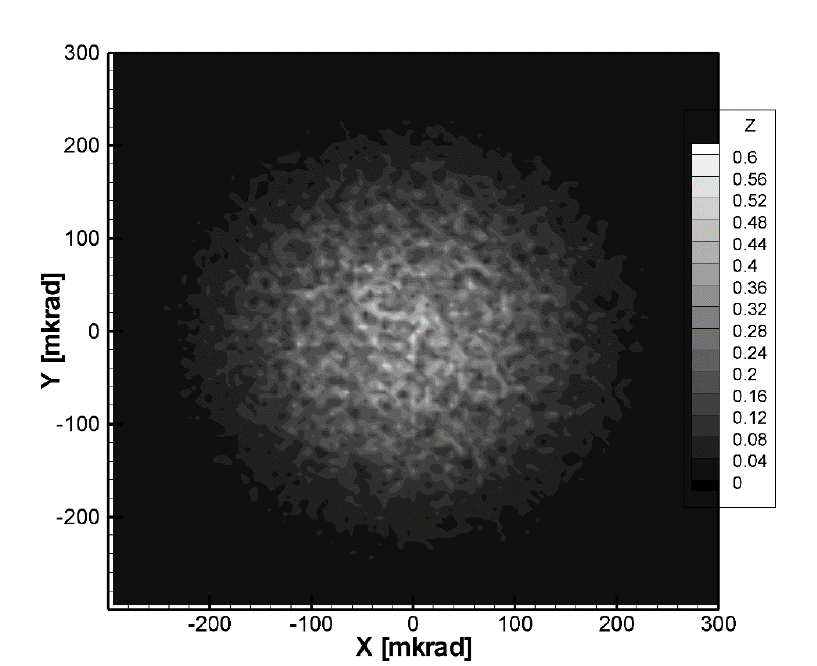
Fig. 1. The distribution of the amplitude in the beam cross section is divergent 3 2 0.3 10    at a distance of 2 km from the source.